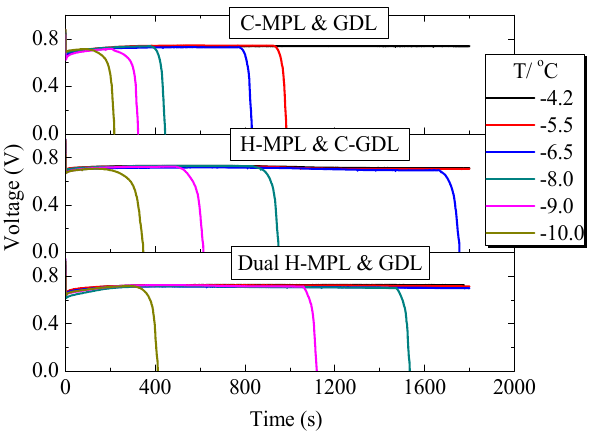
Figure 11. Variation in the voltage of the PEMFC with different structures of MPL/GDL.